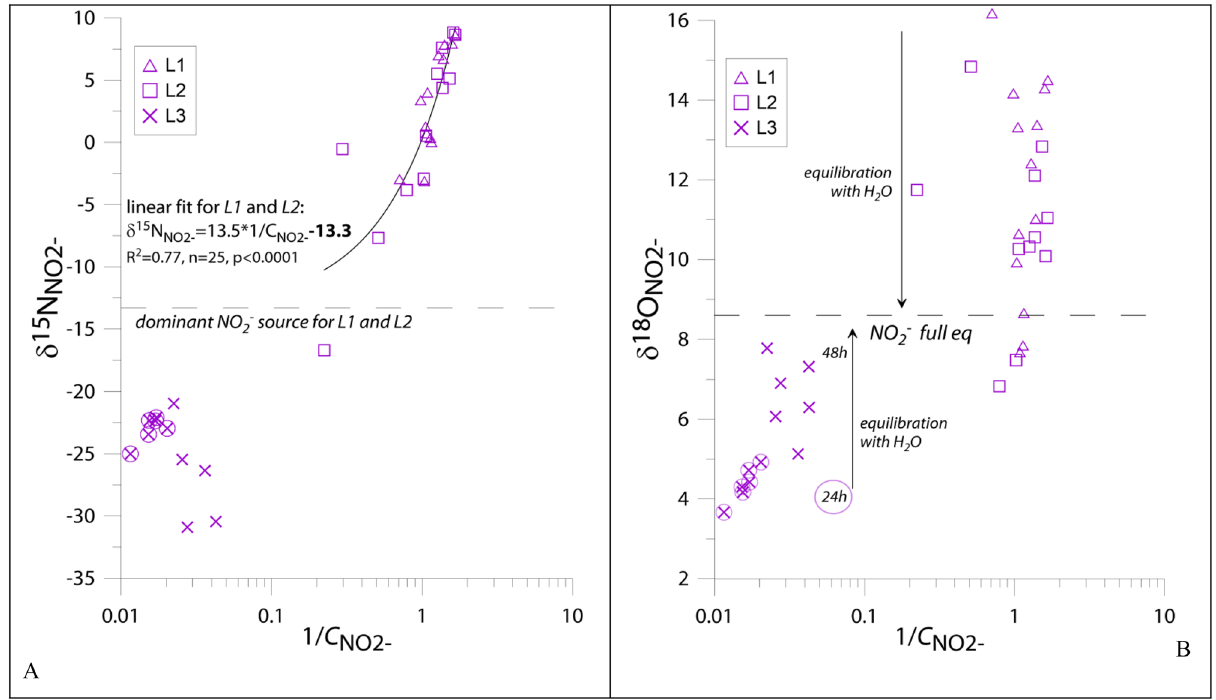
Figure 1. Relationship between NO 2 − isotopic signature δ 15 N NO2− ( A ) or δ 18 O NO2− ( B ) and reciprocal NO 2 − content (Keeling plot analysis—see “Methods” section). For δ 18 O NO2− ( B ) the dashed line indicates the δ value of NO 2 − in full equilibrium with ambient water in 20 °C of 8.6‰ 23 and the arrows indicate the direction of change samples taken after 24 h are marked with circles and the second samples taken after 48 h are shown with crosses only. Note the logarithmic scale of the